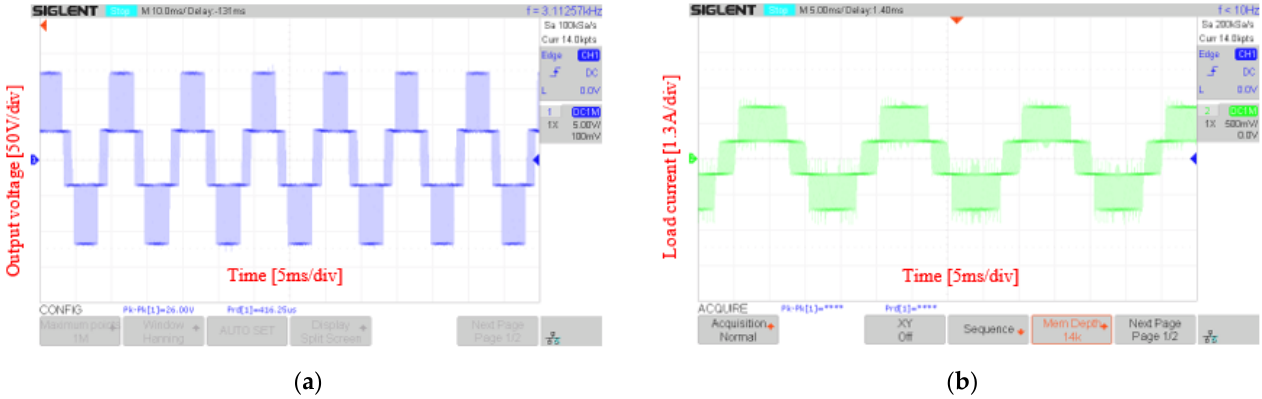
Figure 44. Experimental results of three level-shifted carriers using DSA-LSC method, ( a ) output voltage; ( b ) output current.